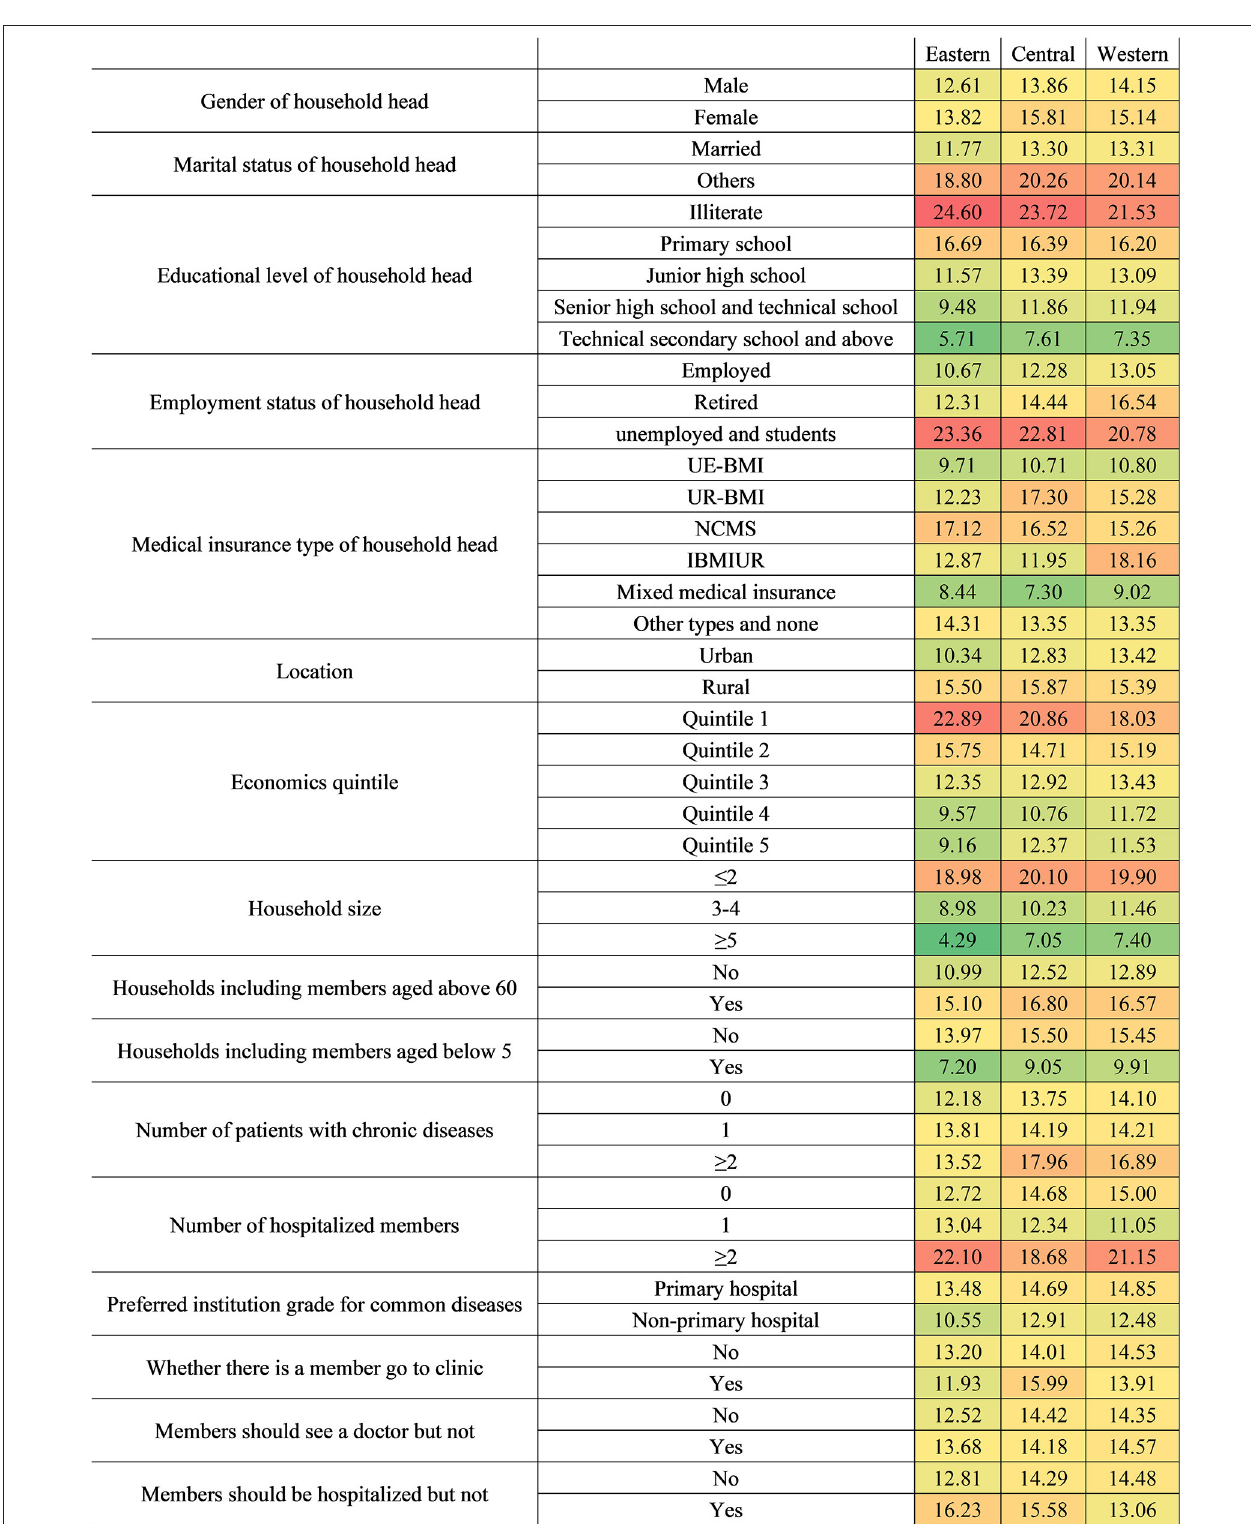
FIGURE 7 | The CHE standardized rate by different areas.